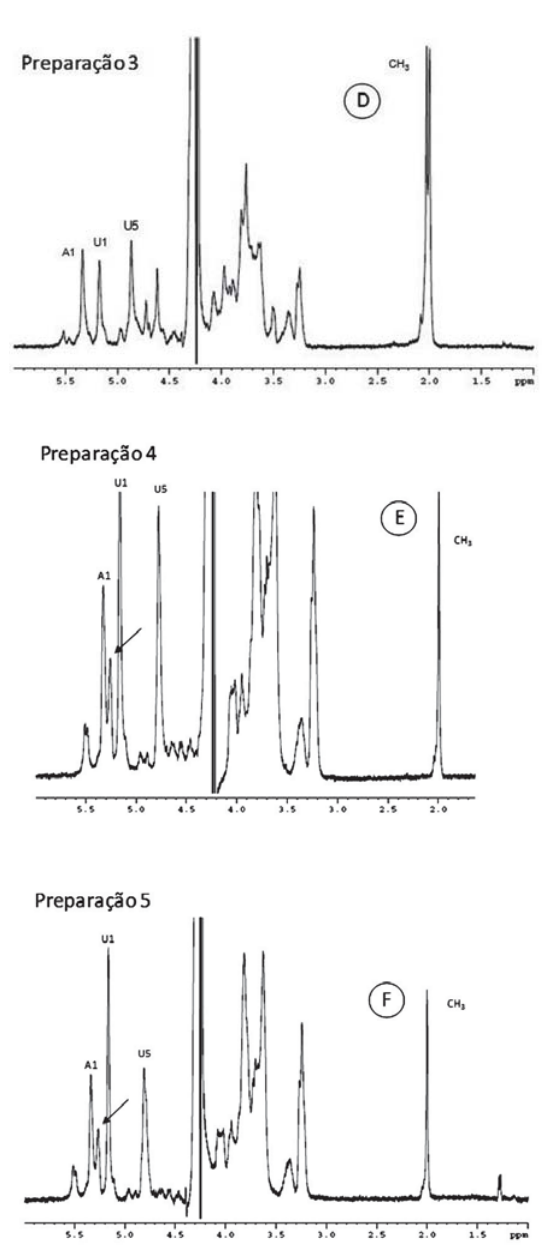
Fig. 3 - Espectro unidimensional de próton do padrão internacional de heparina (A) e de preparações comerciais disponíveis no Brasil (B-F). Observe a semelhança entre os espectros do padrão de heparina (A) e da preparação 1, Liquemine (B). As preparações 2-3 (C e D) contêm um sinal adicional de CH , a aproximadamente 3 2,00 ppm, devido à contaminação com dermatam sulfato. As preparações 4 e 5 (E e F) contêm um sinal adicional de próton anomérico, indicado pela seta no painel. Estudo detalhado dessas preparações de heparina usando espectros bidimensionais de próton mostrou que esse sinal adicional deve-se à presença de resíduos de glucosamina 6-desulfatados